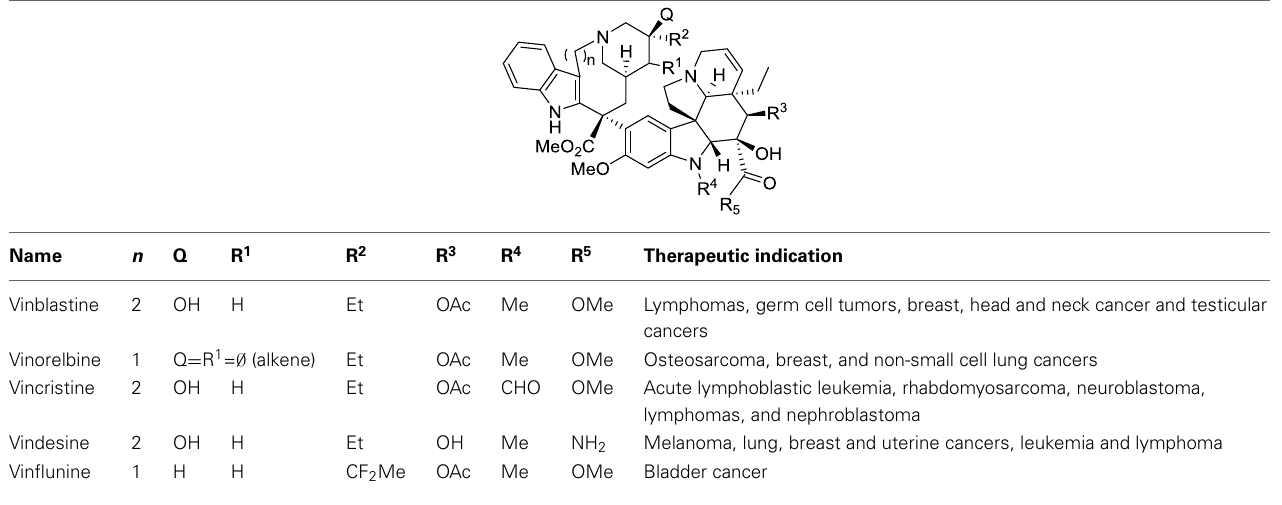
Table 2 | Structures and therapeutic indications of vinca